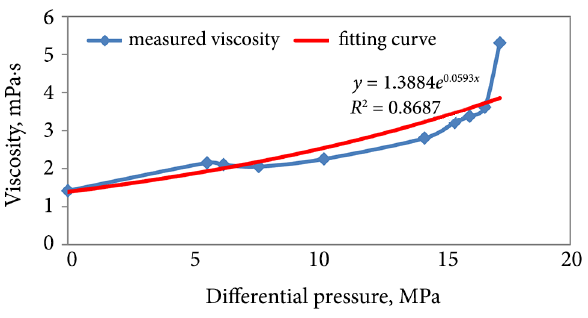
Figure 3. The relationship and the fitting equation between the fluid viscosity of the reservoir and the pressure difference